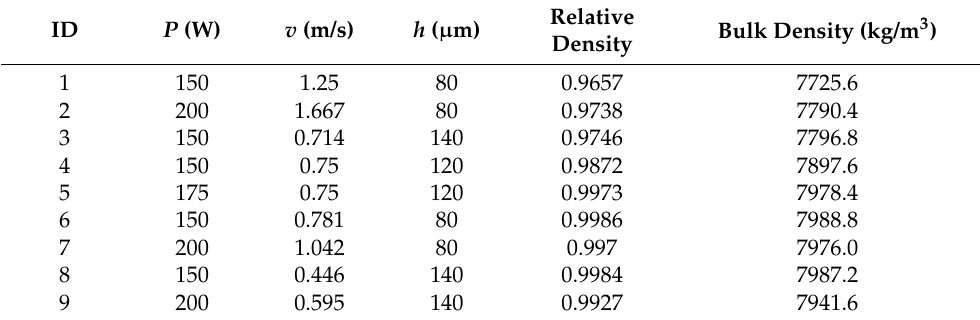
Table A9. Manufacturing parameters and experimental data adapted from [23]. Complement- ing relevant information and assumptions are the following; material: SS316L, theoretical density